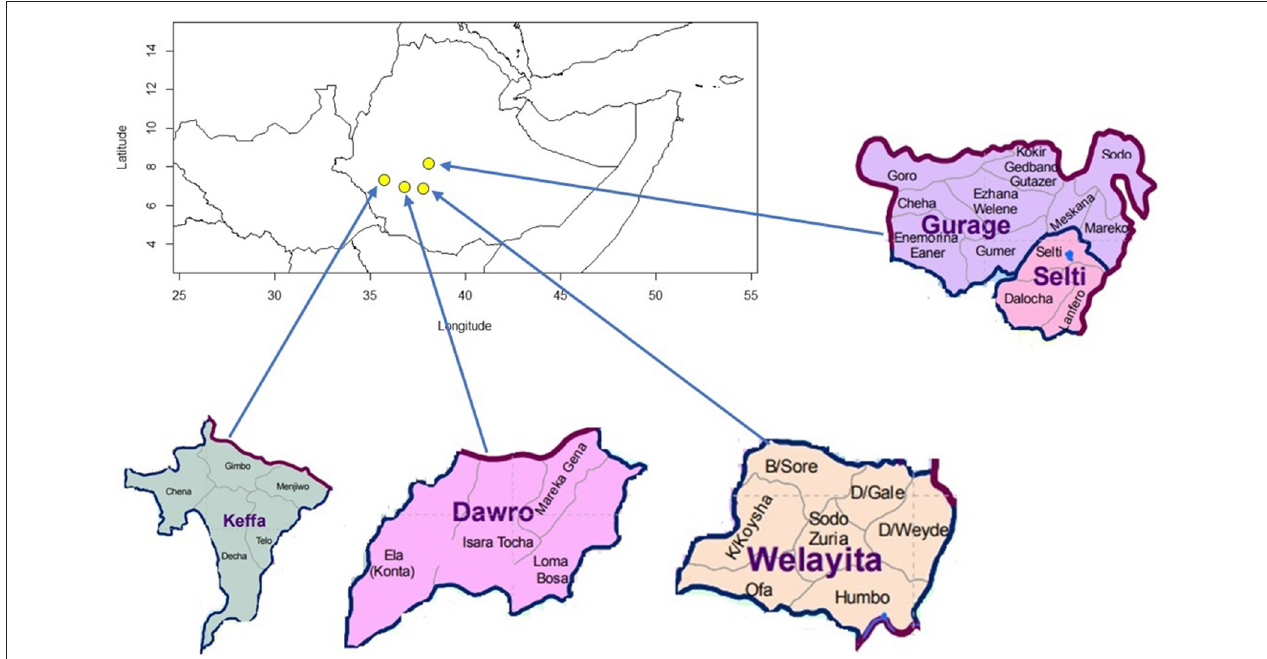
FIGURE 3 | Enset growing zones in southern Ethiopia along with sites where enset suckers were collected.